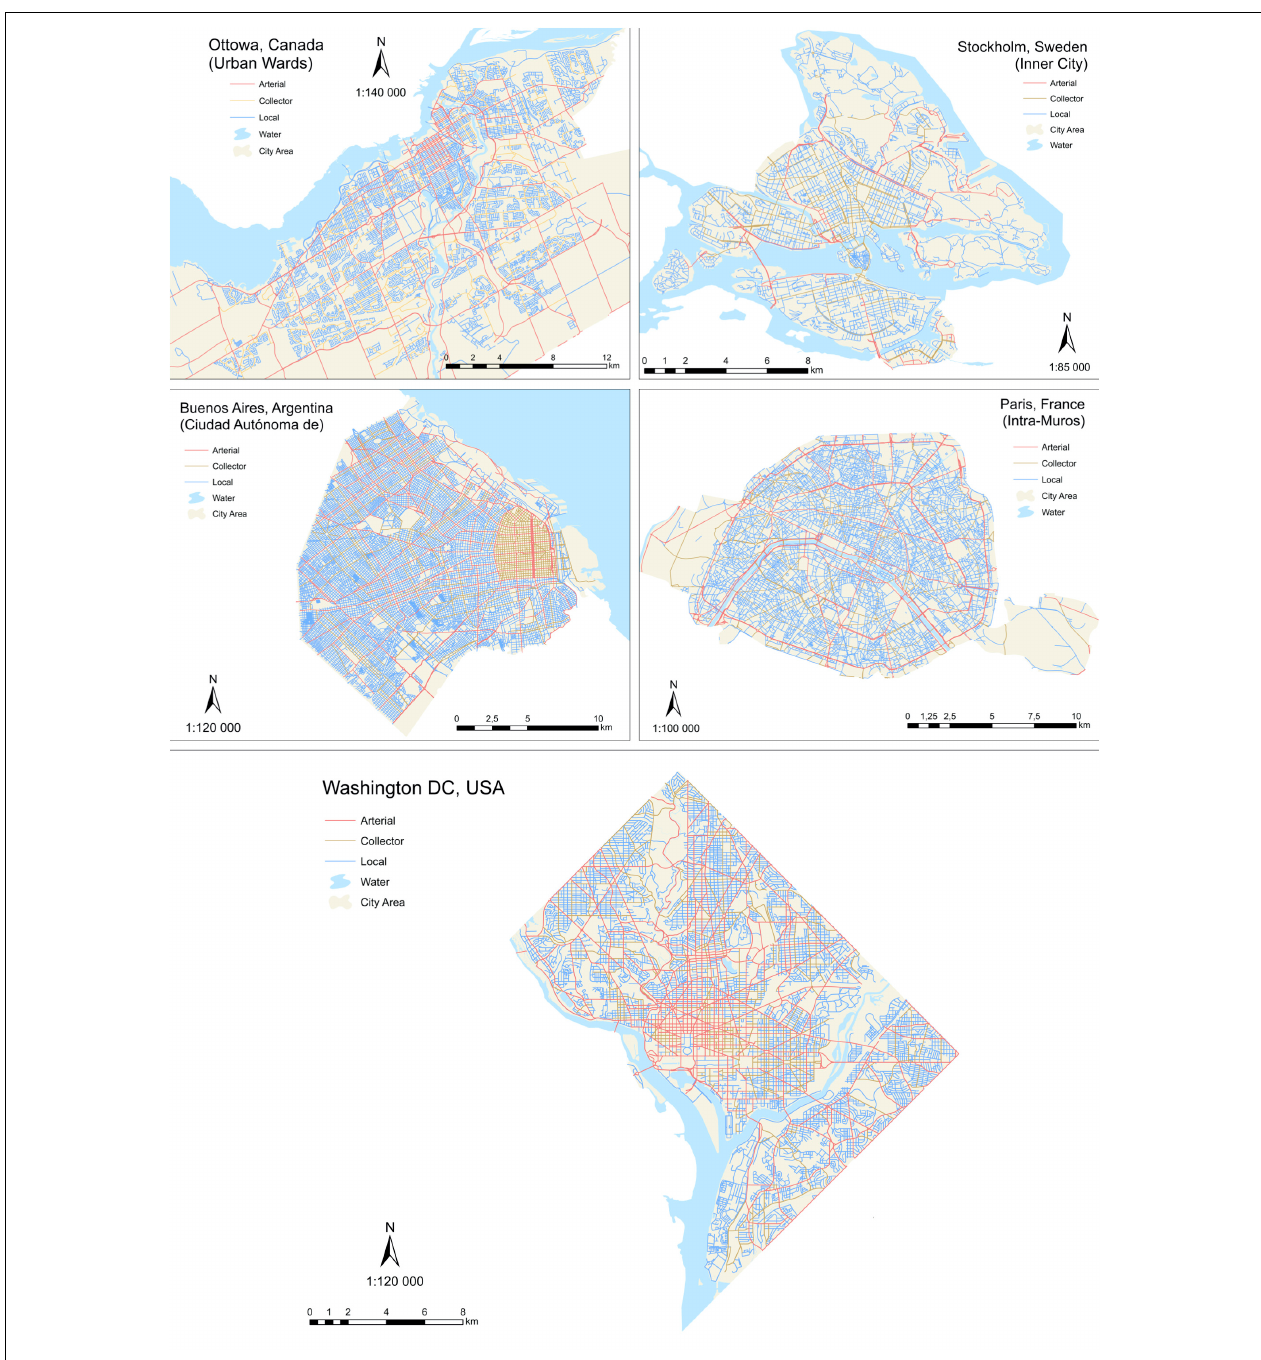
FIGURE 1 | Maps of the central zones and street hierarchies for the five cities in the study.